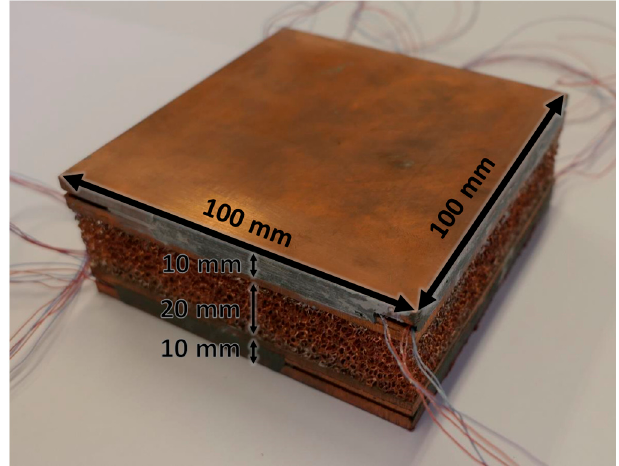
Figure 1. Copper foam with geometrical dimensions.